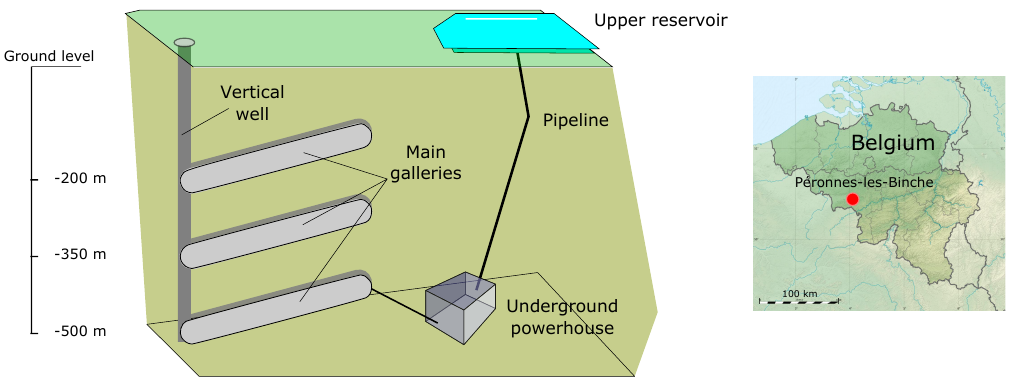
Figure 7. Scheme of the coal mine. The lower reservoir of the UPSH plant consists of three main galleries and the vertical mine